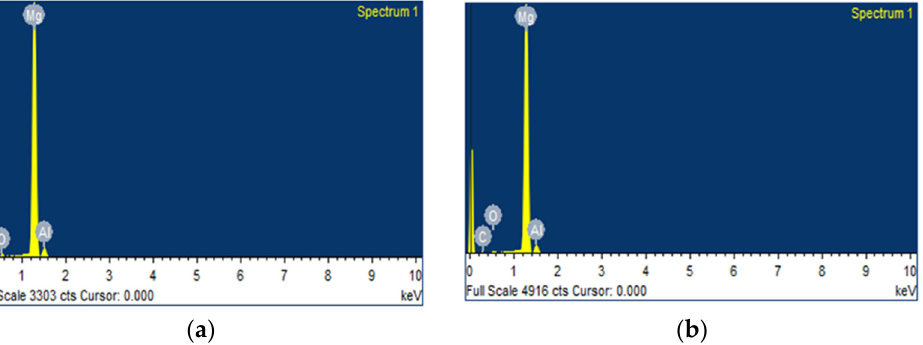
Figure 10. SEM-EDS analysis of the worn surfaces of the Mg AZ91D hybrid composite with varying weight percentages of CF and MWCNT reinforcements. ( a ): AZ91D + 0.5% CFs + 0.5% MWCNT composite; ( b ): AZ91D + 0.75% CFs + 0.75% MWCNT composite.